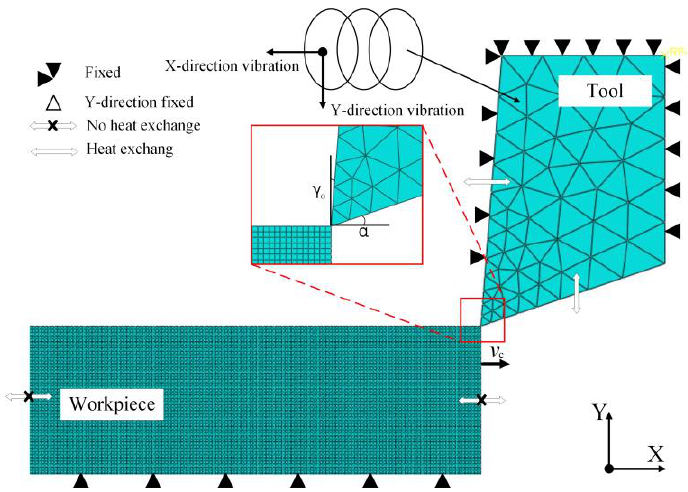
Figure 4. 2D-UEVC simulation model.